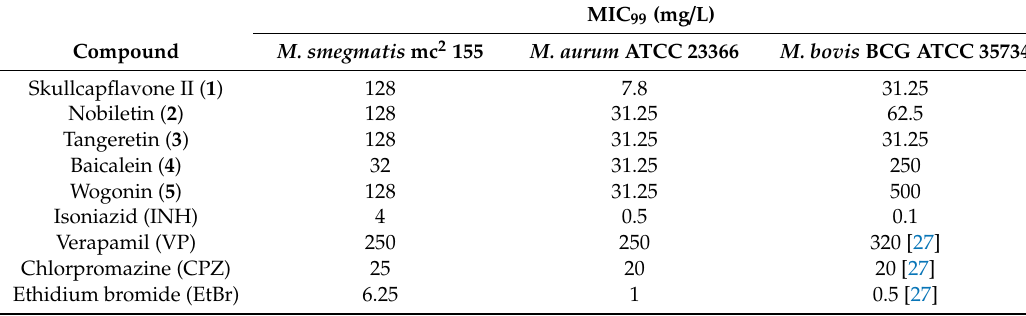
Table 1. Minimum inhibitory concentrations (MICs) of ethidium bromide and e ffl ux pump inhibitors (EPIs) determined for M. smegmatis mc 2 155 using microbroth dilution assay and spot culture growth inhibition (SPOTi)-assay for M. aurum and M. bovis